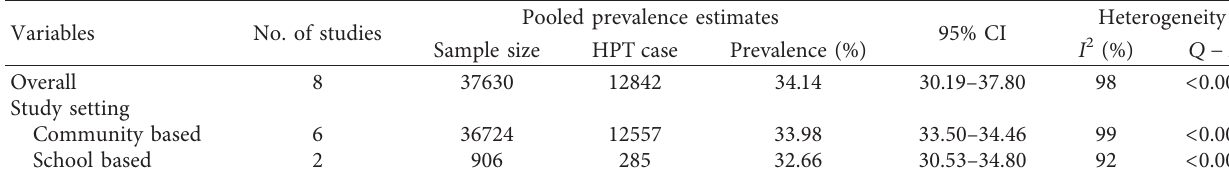
Figure 1: Flow diagram for the selection process of the eligibility study. Table 3: Pooled prevalence estimates for hypertension among the urban population in SEA countries.